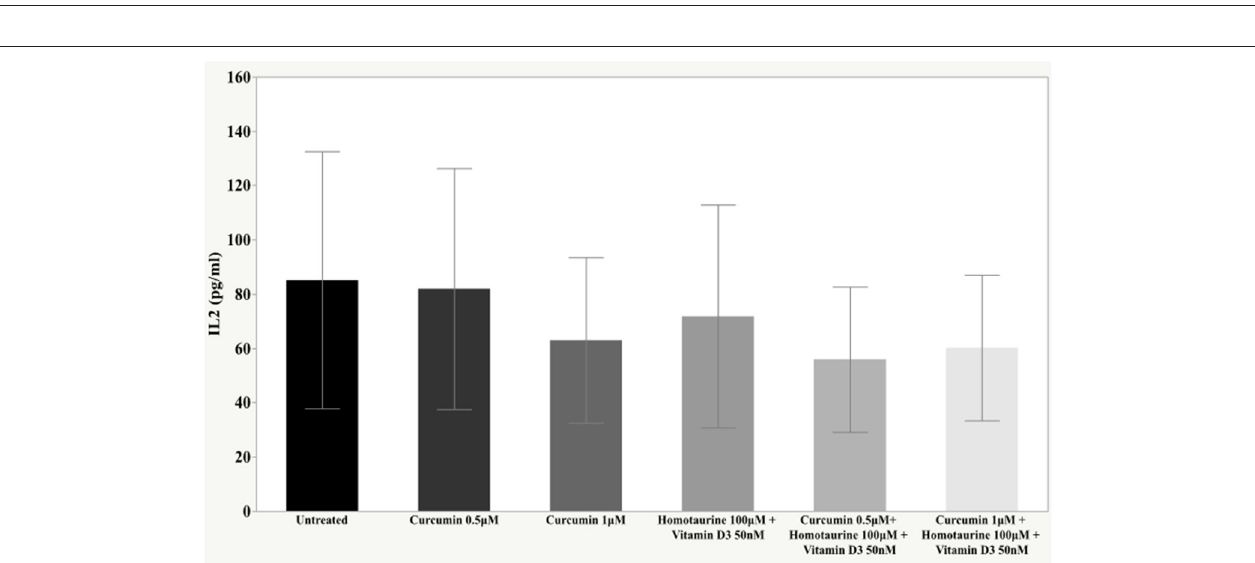
FIGURE 2 | Histogram of the mean and standard deviations of IL2 by experimental